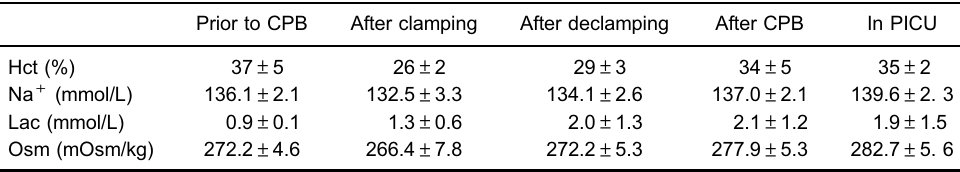
Data are reported as means ± SD. CPB: cardiopulmonary bypass; PICU: pediatric intensive care unit. Two-tailed Student ’ s t- test was used for statistical